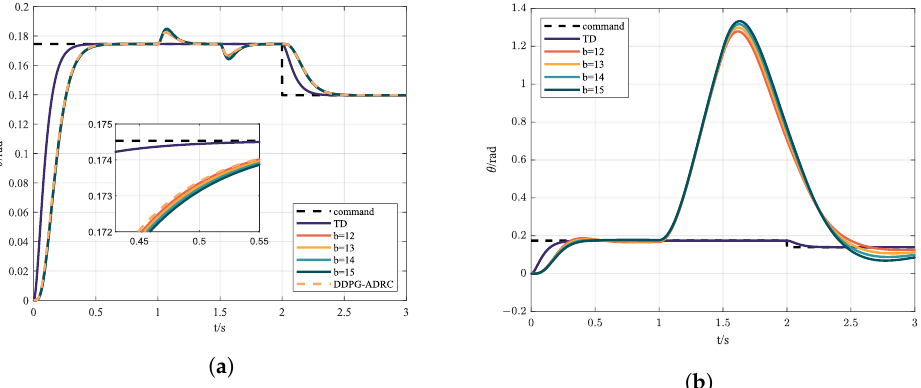
Figure 11. ( a ) Control instruction and state response via ADRC with different b in the presence of external disturbances; ( b ) control instruction and state response via MPC with different b in the presence of external disturbances.